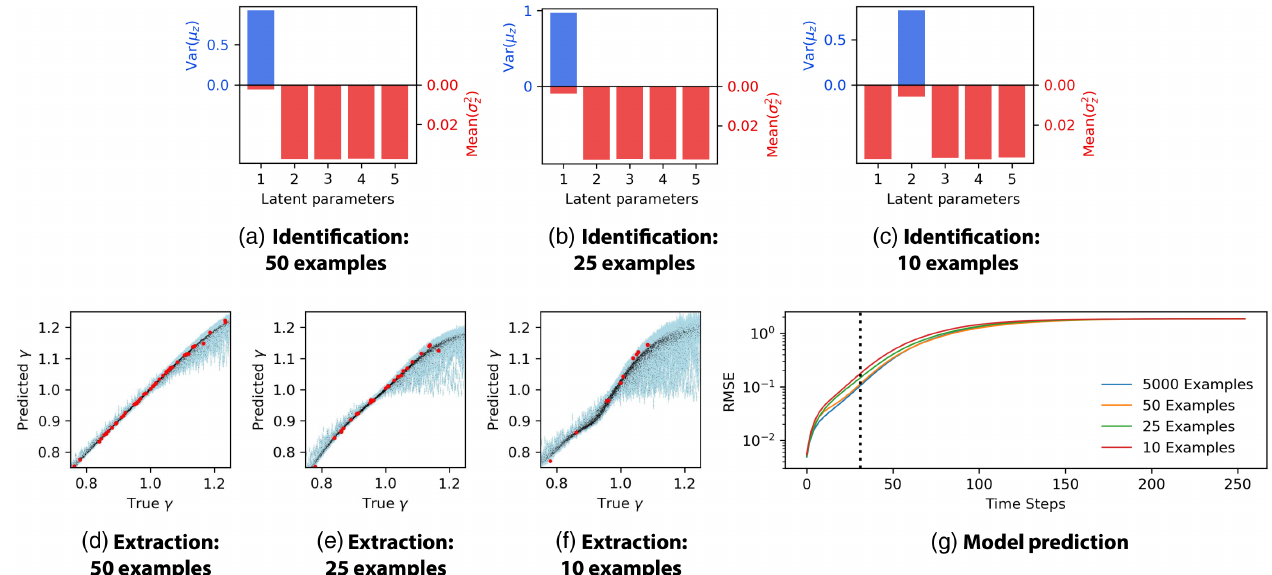
FIG. 8. Parameter extraction and prediction performance for models trained on noiseless 1D Kuramoto-Sivashinsky datasets with 50, 25, and 10 examples to show the effect of dataset size. The (a) – (c) parameter identification and (d) – (f) extraction plots demonstrate the ability of the model to identify and extract a relevant latent parameter using very few examples. In the extraction plots, the small black points show the evaluation on the test set, the large red points show the training examples used for each model, and the light blue shaded bars are the 95% confidence intervals produced by the model. There is also a subtle decrease in prediction performance seen in (g) the RMSE averaged over the 10 000 example test set. The parameter identification and extraction plots for the 5000 example dataset are shown in Figs. 2(a) and 3(a),